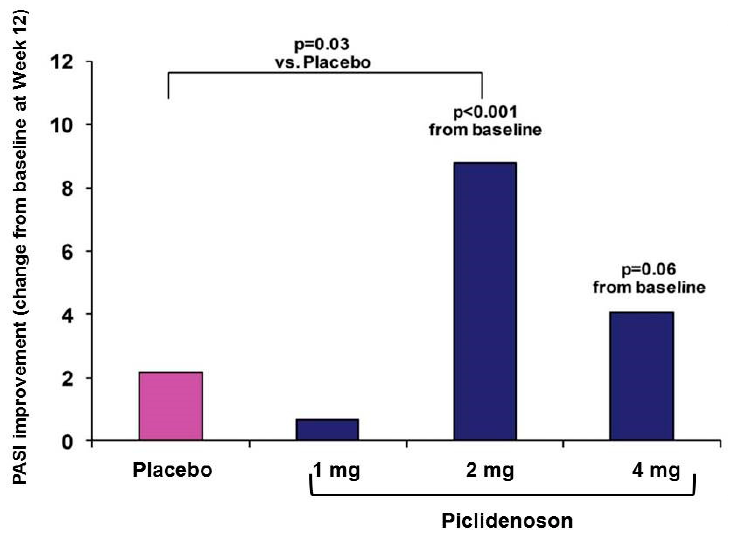
Figure 3. Change from baseline in PASI score by piclidenoson dose at week 12 [40].